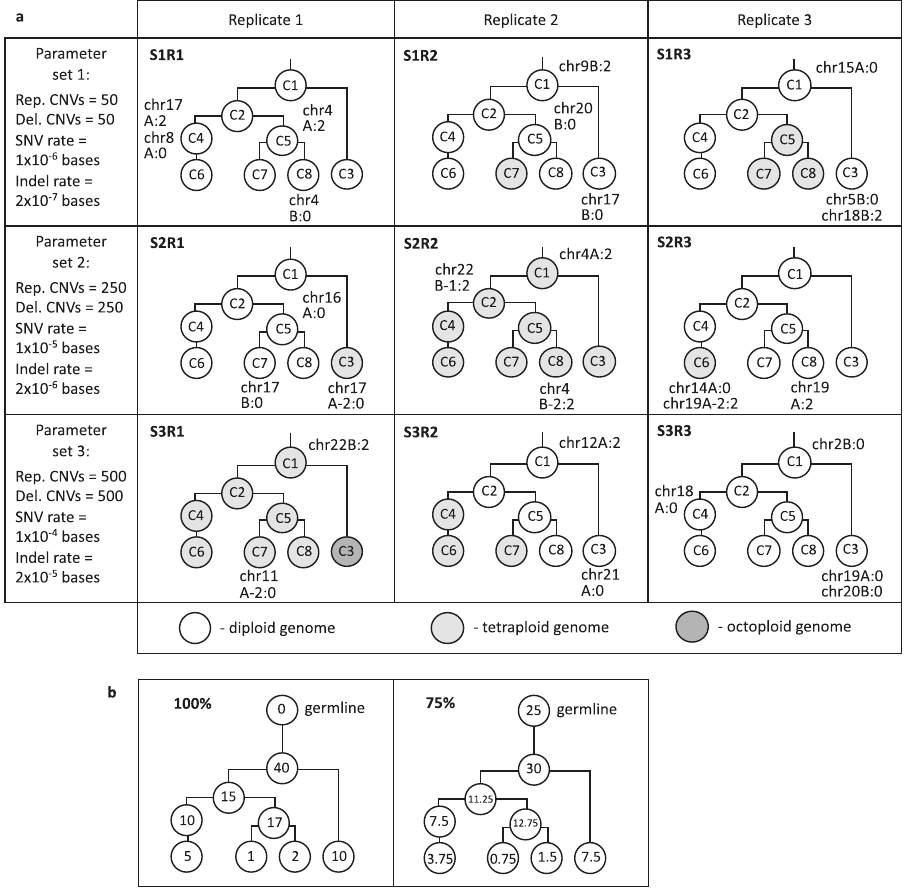
Fig. 1 The ground truth datasets. a Tumour clonal architectures created by HeteroGenesis. Clones are denoted C1 to C8. Single chromosome aneuploid events are indicated next to the clone in which they fi rst appear, but are also present in all daughter clones. Three different parameter sets (S1 to S3) were used to de fi ne total somatic mutation numbers in each tumour, with three replicates created for each set (R1 to R3). b Clone and germline proportions represented in the bulk samples, with numbers in circles representing the relative proportions of reads from each, for 100 and 75% tumour purities. 50 and 25% samples were similarly created for a subset of tumours. CNV copy number variation, chr chromosome, Rep replication, Del deletion, SNV single- nucleotide